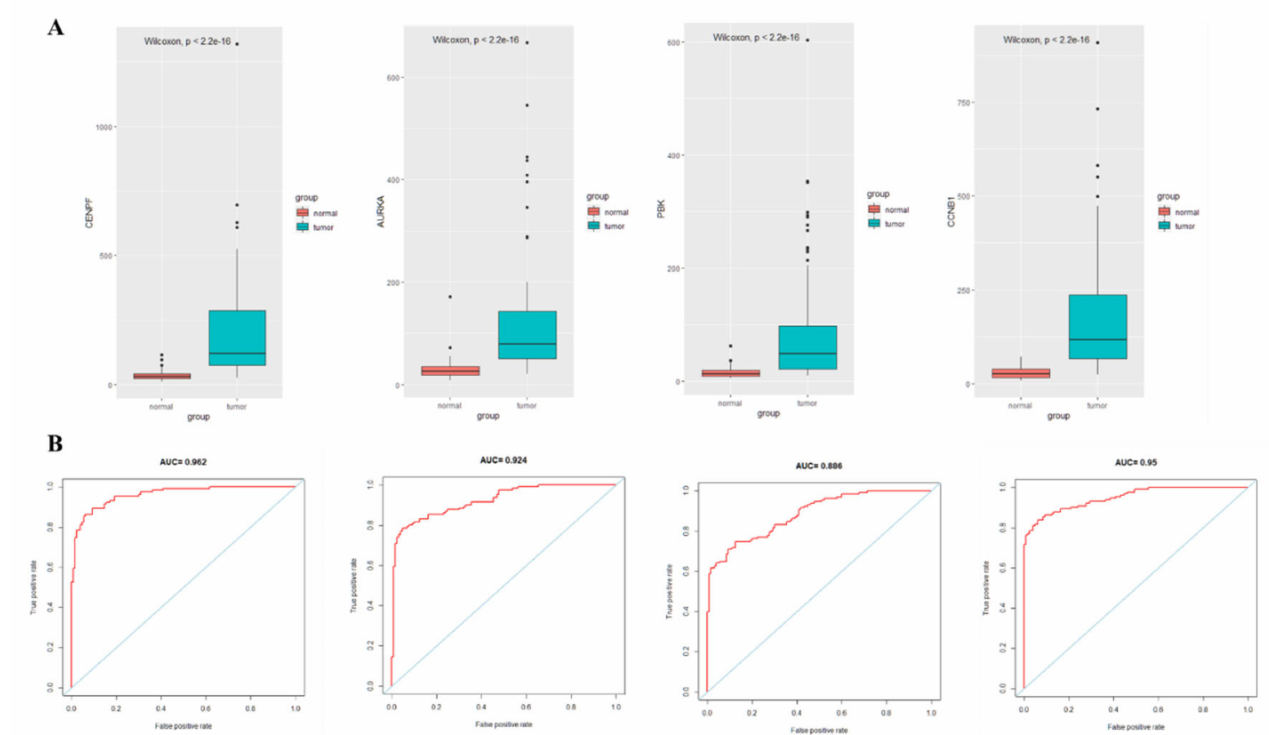
Figure 6. Expression and ROC curve analysis of hub gene in lung cancer tissue and adjacent normal lung tissue. ( A ): Hub gene expression; ( B ): ROC curve analysis of hub